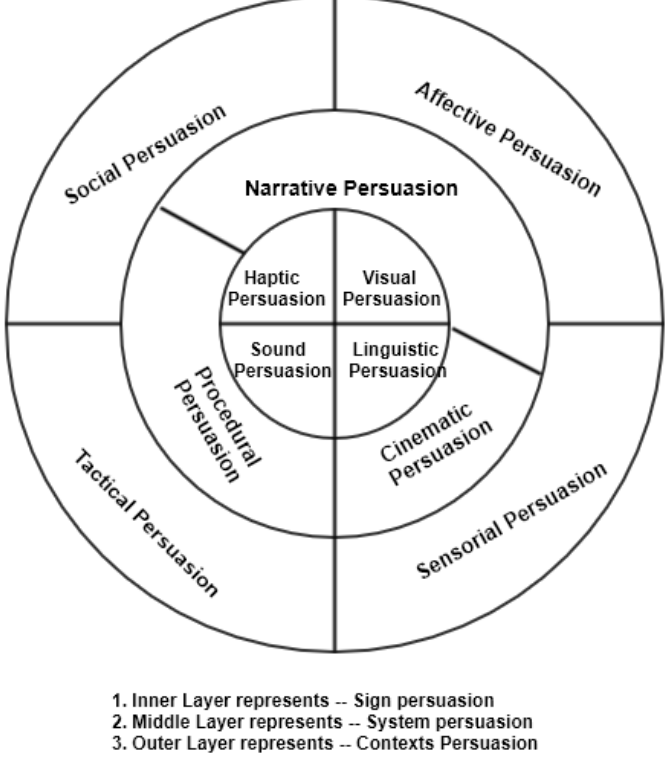
Figure 2. Knowledge model for CybAR Figure 13: Knowledge Model for Persuasive Game - Teresa De La Hera Model